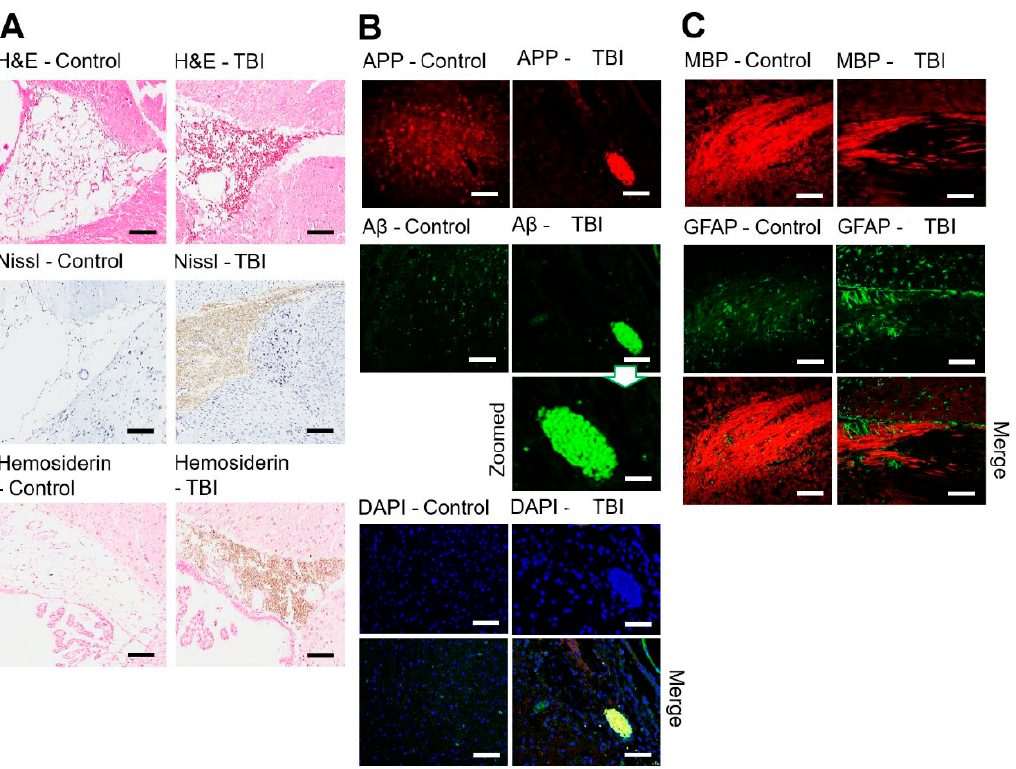
Figure 2. ( A ) Immunohistochemical comparison of the control and mTBI brain tissue areas (ROI) for H&E, Nissl and Hemosiderin staining. ( B ) Healthy control and injured brain sections labeled with APP (red), A β 1–42 (green) and degenerated neurons with shrunken nuclei DAPI (blue) for the Co region. A β 1–42 aggregation is shown. ( C ) CC region and disorganization of the myelin sheath (MBP, red) of the axonal neurons in the injured white matter are labeled with APP (red) and indicated activated astrocytes (GFAP, green stain). Scale bar = 100 μ m and 20 μ m (zoomed).